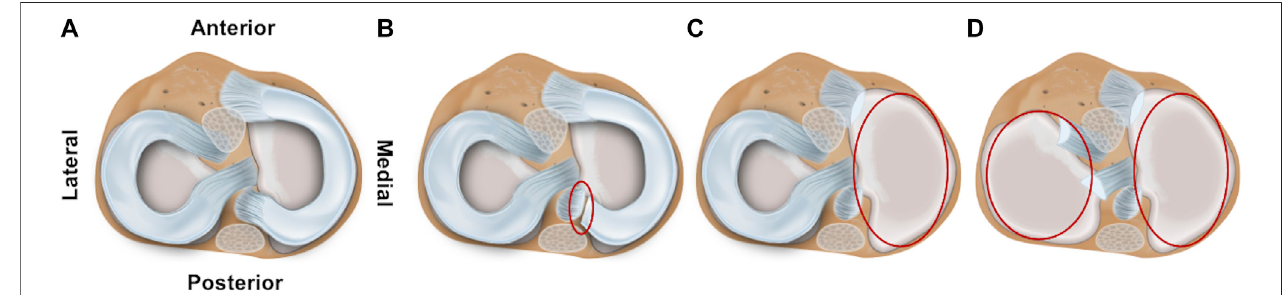
FIGURE 1 | Schematic drawing of the axial view on a tibial plateau of a left knee joint. The femur is removed to allow better visualization of the four investigated meniscal states: (A) intact, (B) avulsion of the posterior medial meniscus horn, (C) medial meniscectomy, and (D) total lateral and medial meniscectomy.